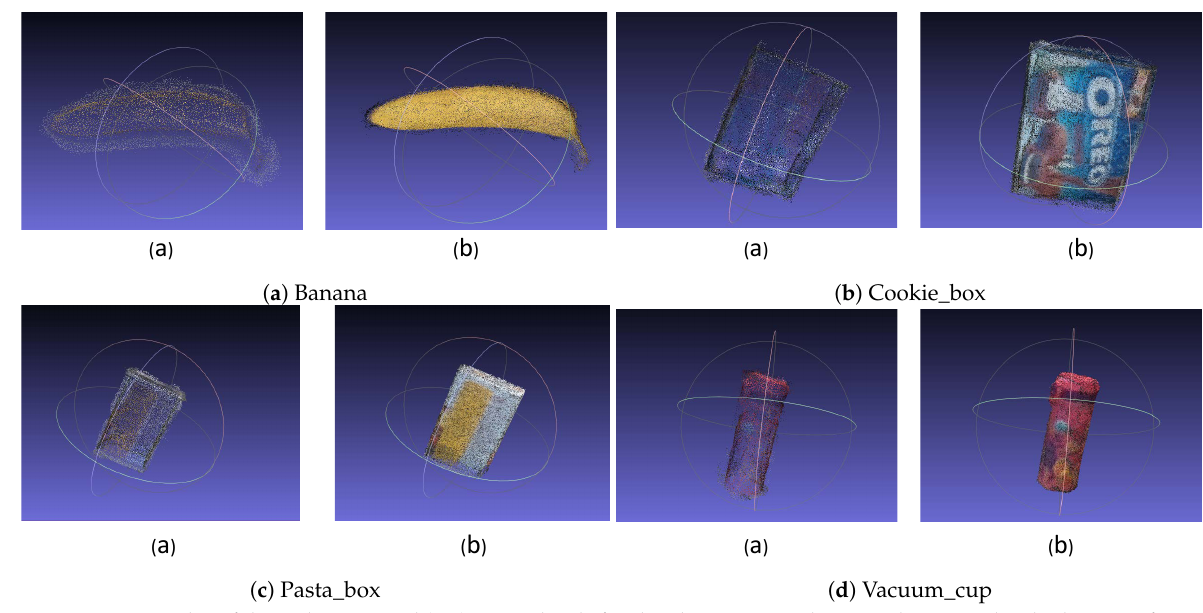
Figure 12. Examples of three-dimensional (3D) point clouds for the objects in our dataset. The point clouds shown in figures (a) and (b) are generated by COLMAP and our approach, respectively.